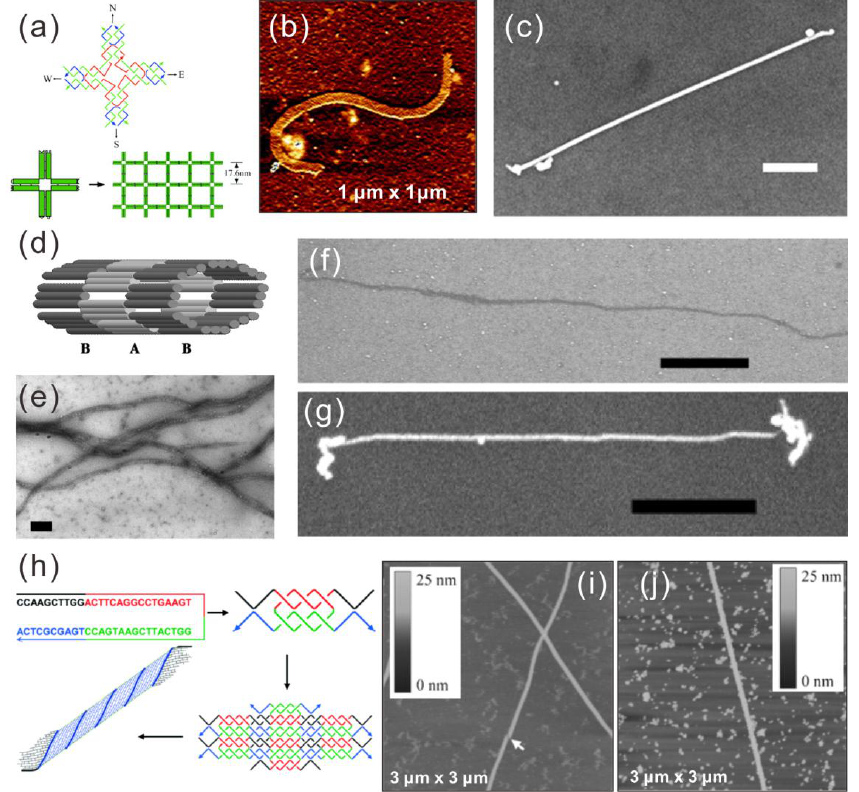
Figure 2. Upper panel ( a – c ) [23]: (a) schematic of a 4 × 4 tile and nanoribbon assembly form from these tiles; (b) AFM image of a nanoribbon; (c) SEM image of a metallized silver nanoribbon, scale bar 500 nm; middle panel ( d – g ) [87]: ( d ) scheme of a nanotube made of TX tiles; (e,f) TEM and SEM image of nanotubes; (g) SEM image of a metallized silver nanotube; scale bars in (e–g) are 100 nm, 1 μm and 1 µ